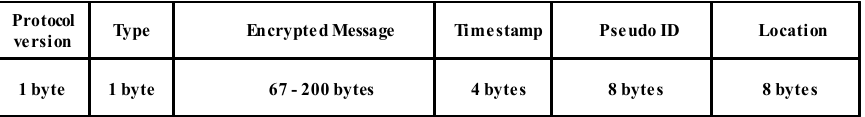
Figure 17. The format of an encrypted message for member vehicle.